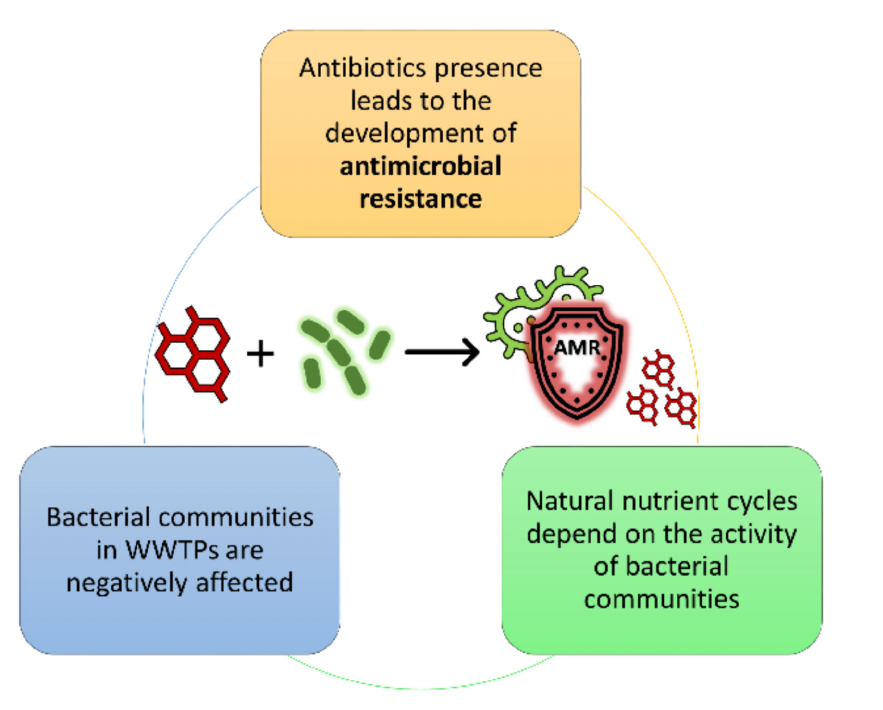
Figure 3. Concerns associated with antibiotics presence in the aquatic